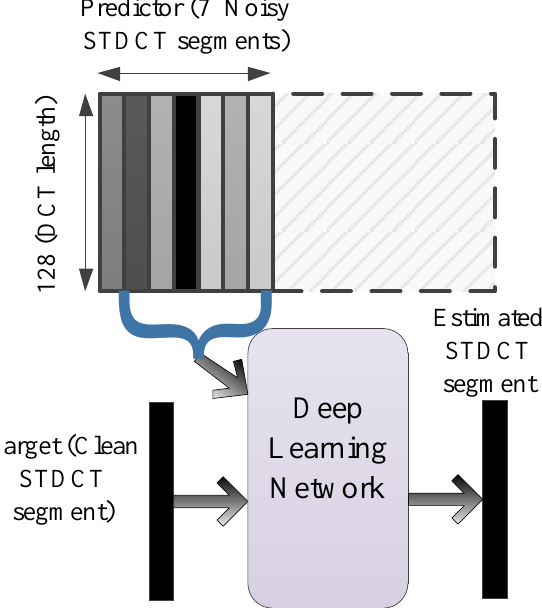
Figure 1. Schematic diagram of the denoising method. Seven STDCT segments are fed to the deep convolutional neural network to get a clean STDCT segment.